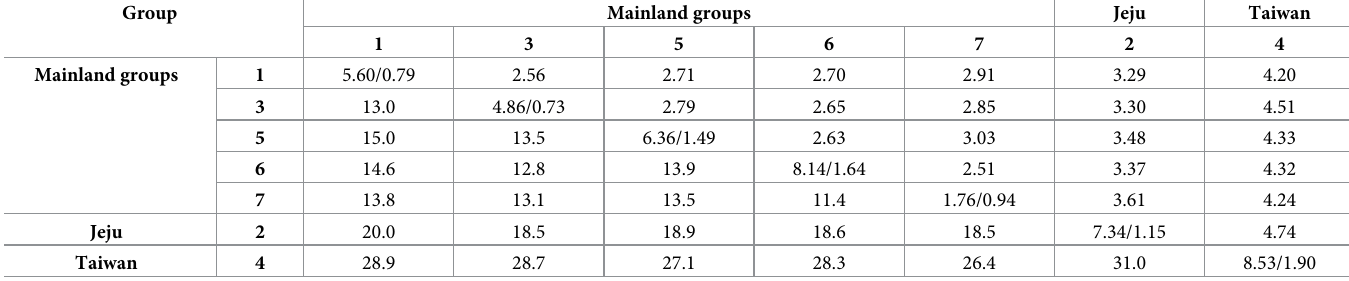
under diagonal–mean between group distances ( × 10 − 3 ); above diagonal–S.E. ( × 10 − 3 ); bias–mean within group distance / S.E ( × 10 − 3